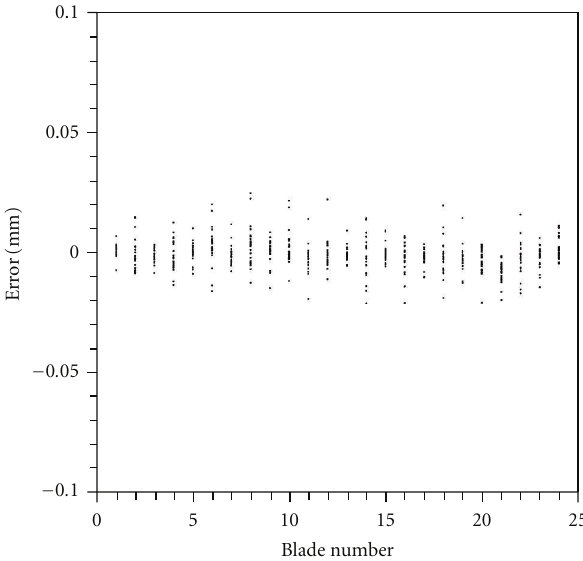
Figure 14: Error in FM capacitance probe measurement calculated after compensating for bearing eccentricity.